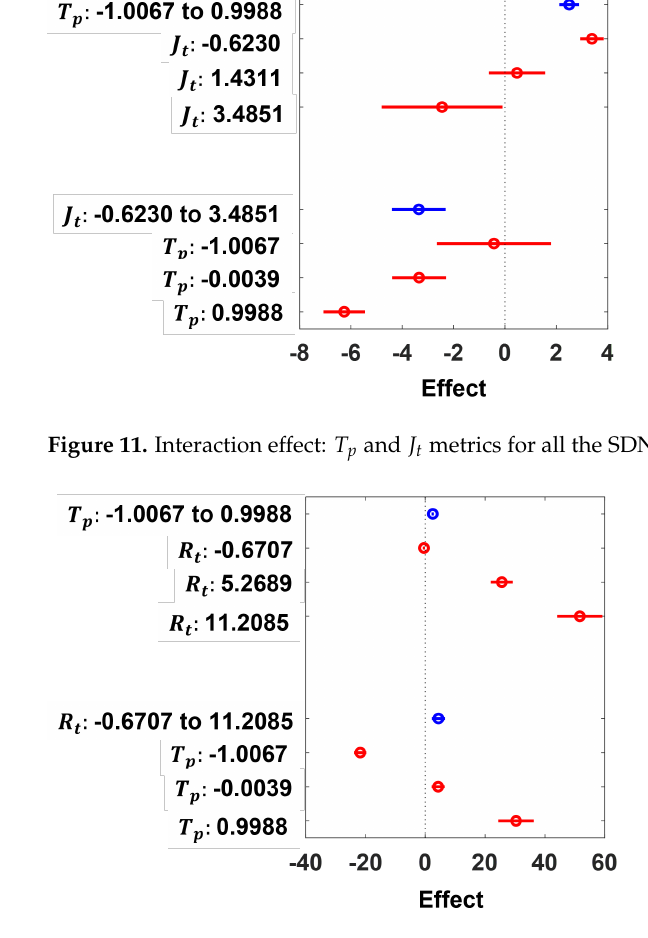
Figure 12. Interaction effect: T p and R t metrics for all the SDN scenarios.